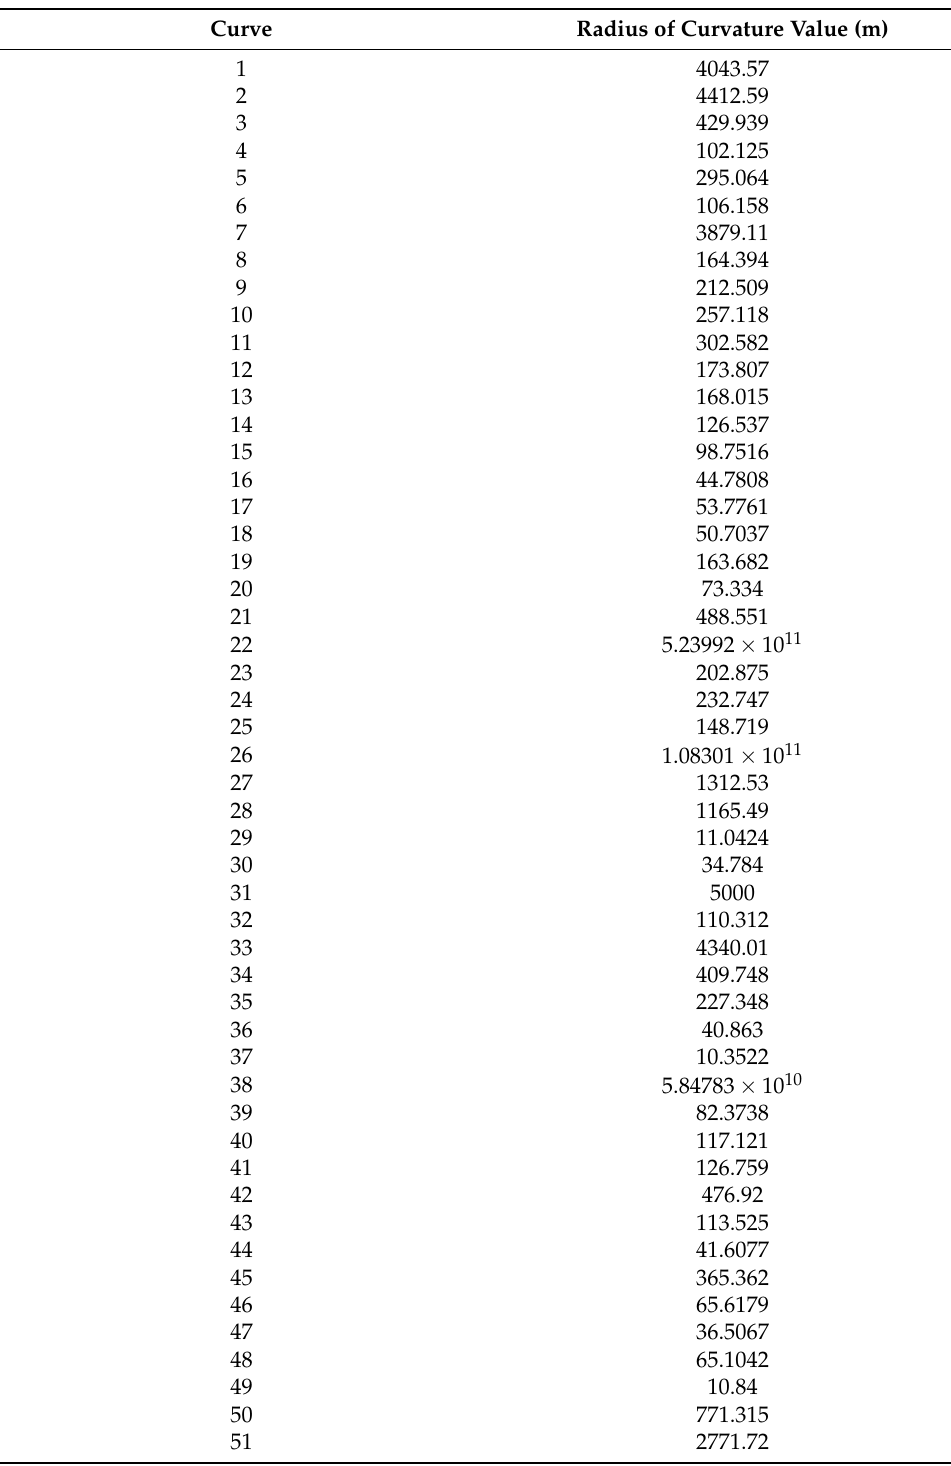
Table A3. Radius of Curvature Value.